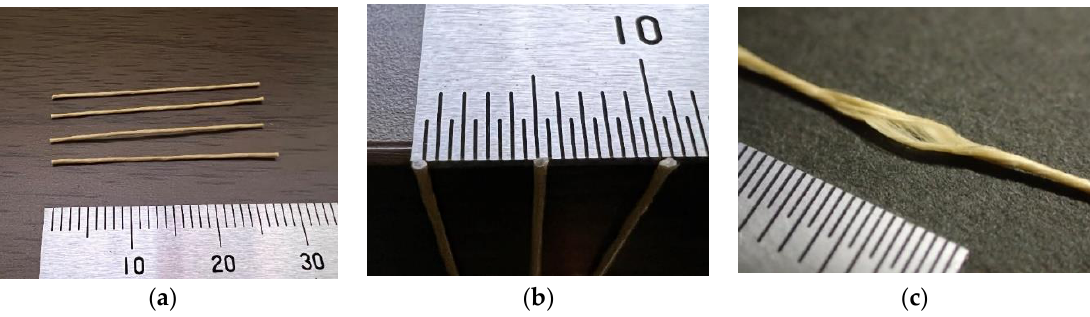
Figure 1. Bundled aramid fiber used in this study: ( a ) chopped fiber with 30 mm length; ( b ) close-up of the cross-section; ( c ) condition of bundling of yarns. Table 1. Mechanical characteristics of bundled aramid fiber.